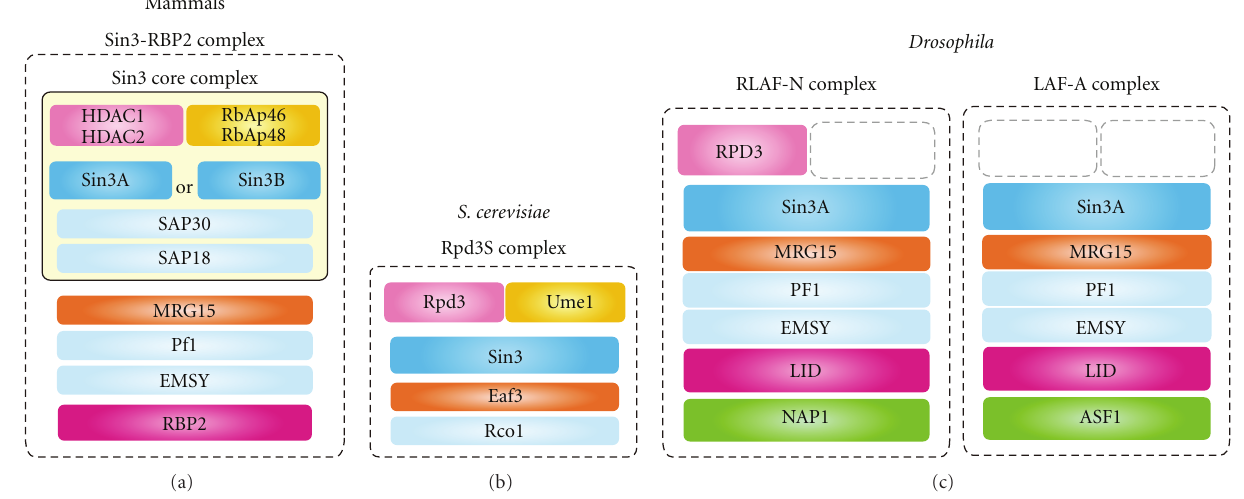
Figure 1: The Sin3 complexes. Schematic representation of the Sin3-containing HDAC complexes: (a) the Sin3-core and Sin3-RBP2 complexes in mammalian cells; (b) the Rpd3S complex in S. cerevisiae ; (c) RLAF-N and LAF-A complexes in Drosophila . The empty dotted boxes indicate missing subunits compared with the Sin3-core